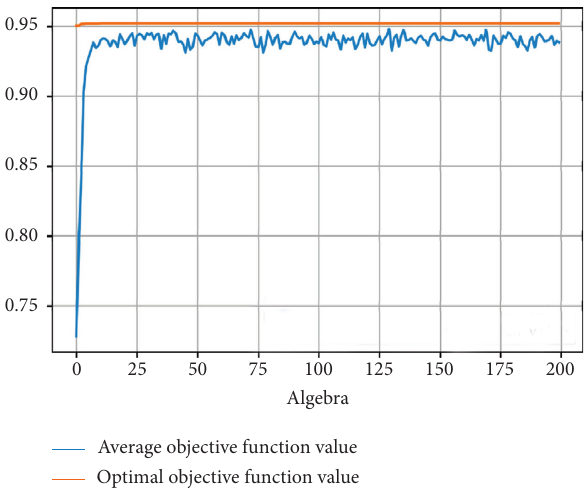
Figure 9: Improved genetic algorithm optimization results.